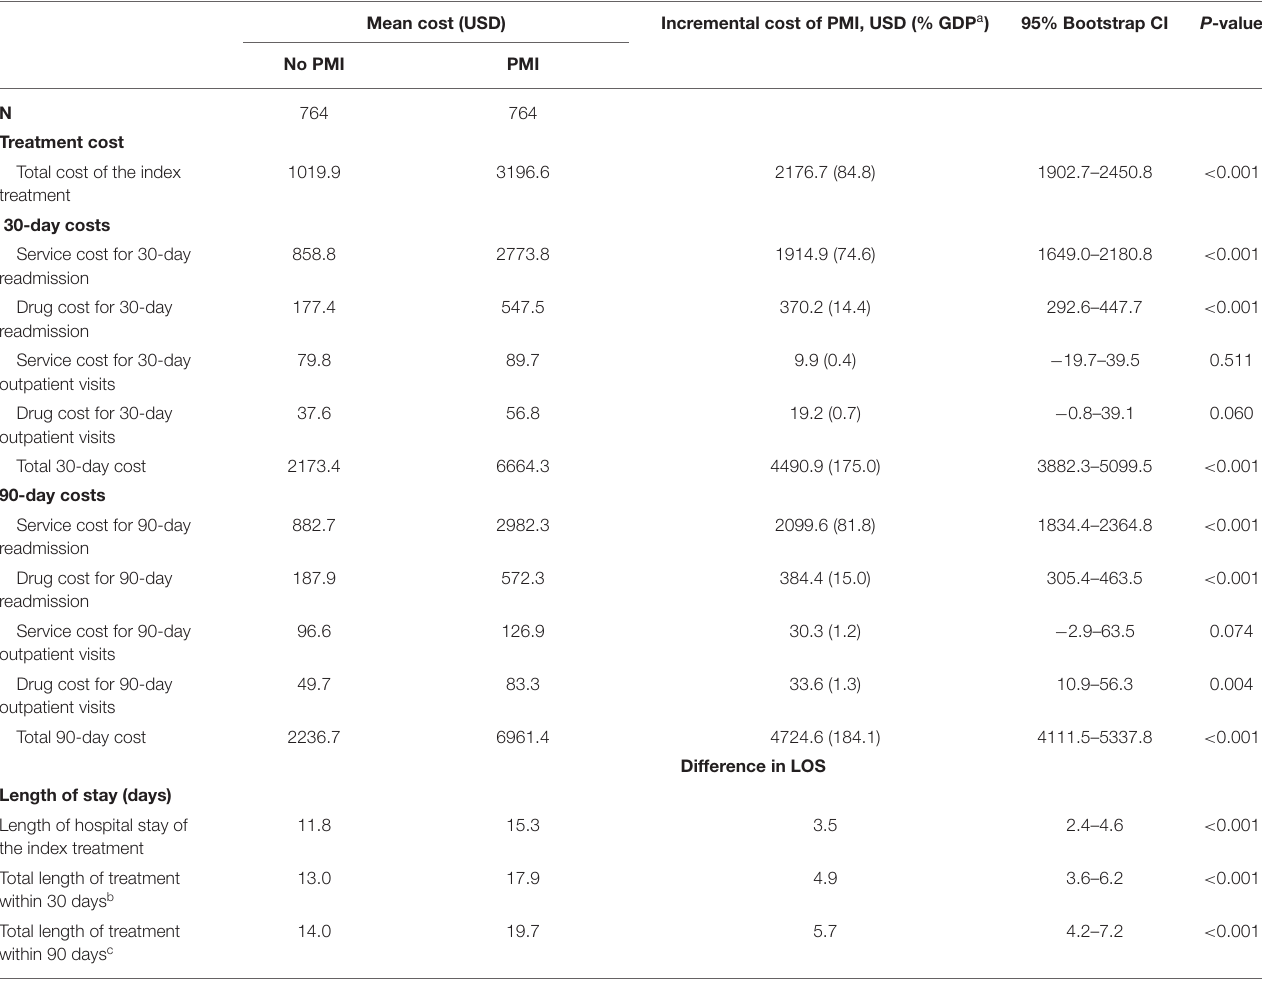
TABLE 3 | Incremental costs and length of hospital stay due to post-operative myocardial infarction